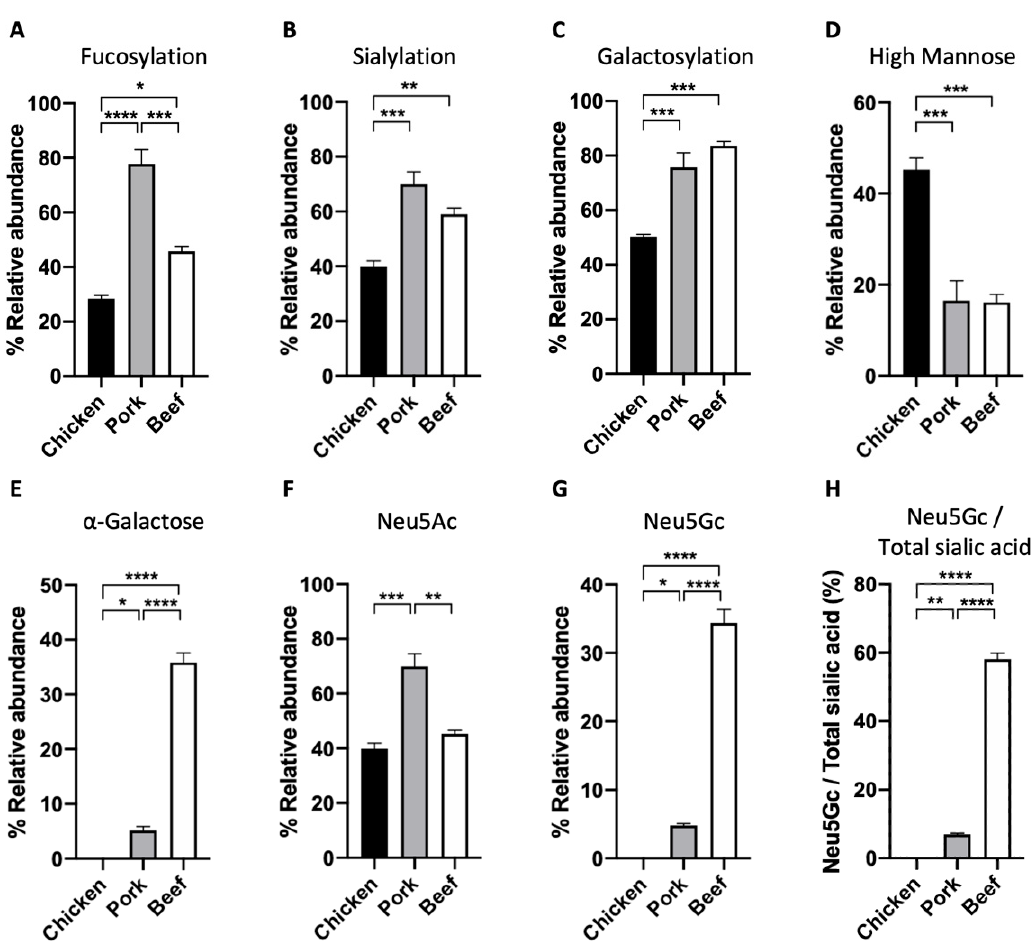
Figure 5. The relative abundance of ( A ) core fucosylation, ( B ) sialylation, ( C ) galactosylation, ( D ) high mannose, ( E ) α -galactose, ( F ) N-acetylneuraminic acid (Neu5Ac), and ( G ) N-glycolylneuraminic acid (Neu5Gc) measured in N-glycans of chicken, pork, and beef. ( H ) Ratio of Neu5Gc and total sialic acid was also calculated. (One-way ANOVA followed by Tukey’s post hoc test, n = 4 independent biological replicates; * p < 0.05; ** p < 0.01; *** p < 0.001; **** p < 0.0001.)